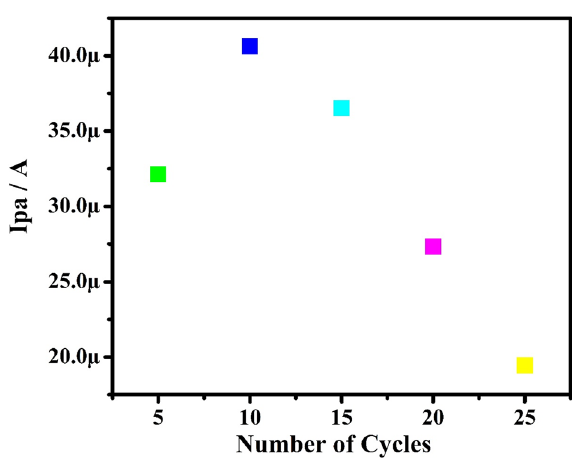
Figure 2. Graph of Ipa vs number of voltammetric scans.